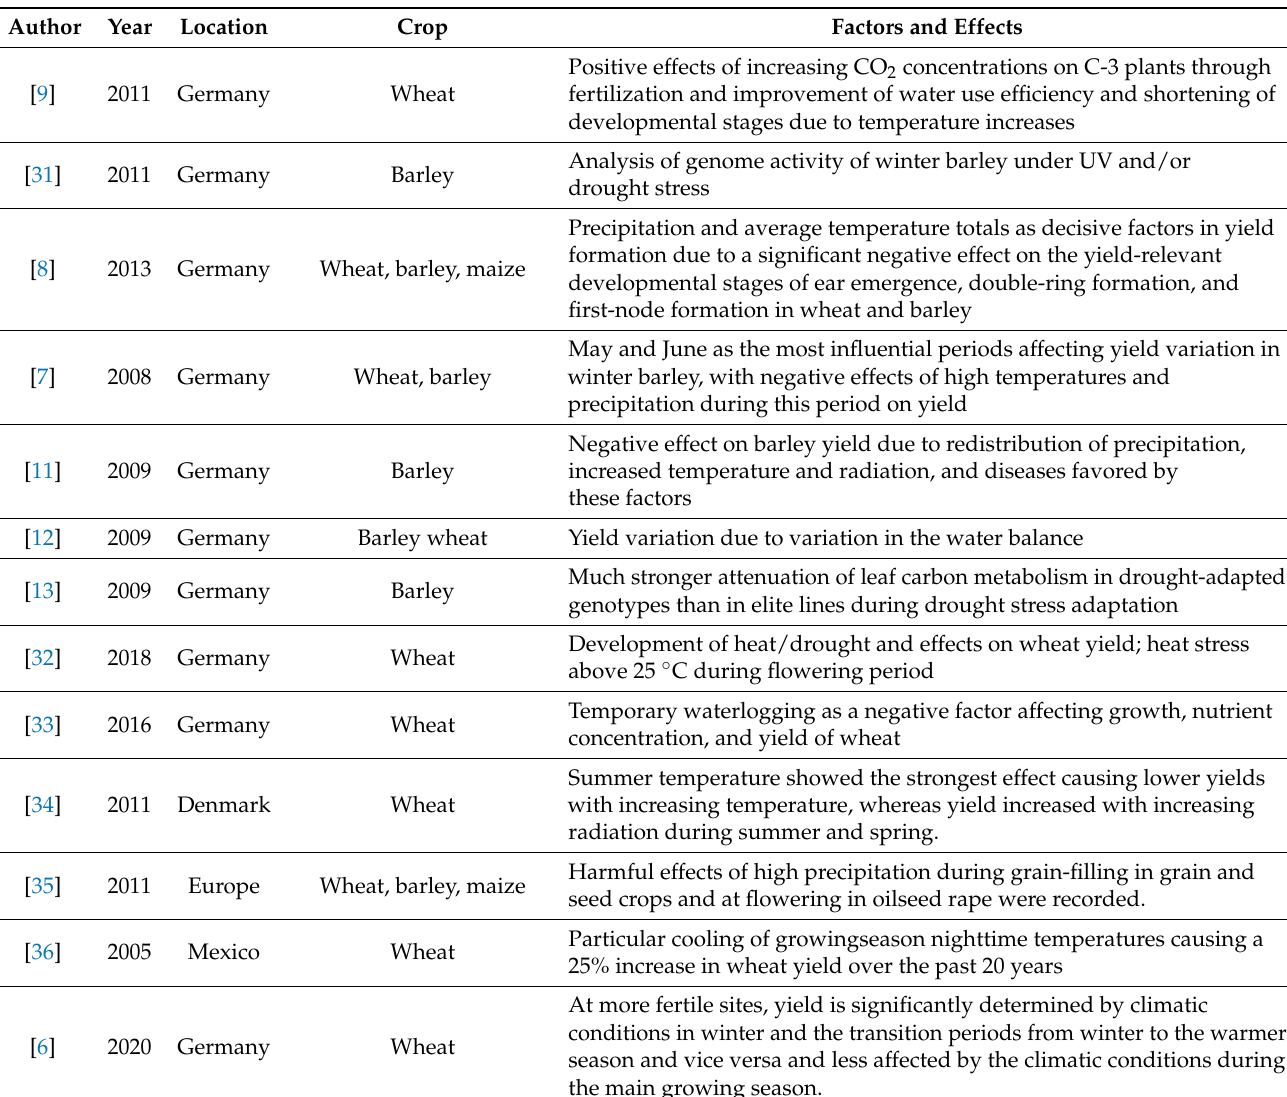
Table 1. Literature overview of various studies investigating the effect of climate on barley, wheat, and maize grain